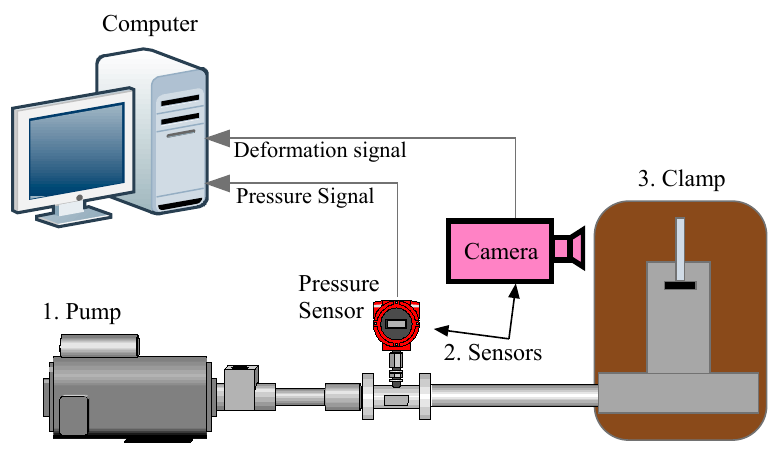
Figure 2. The hydraulic bulge test device.